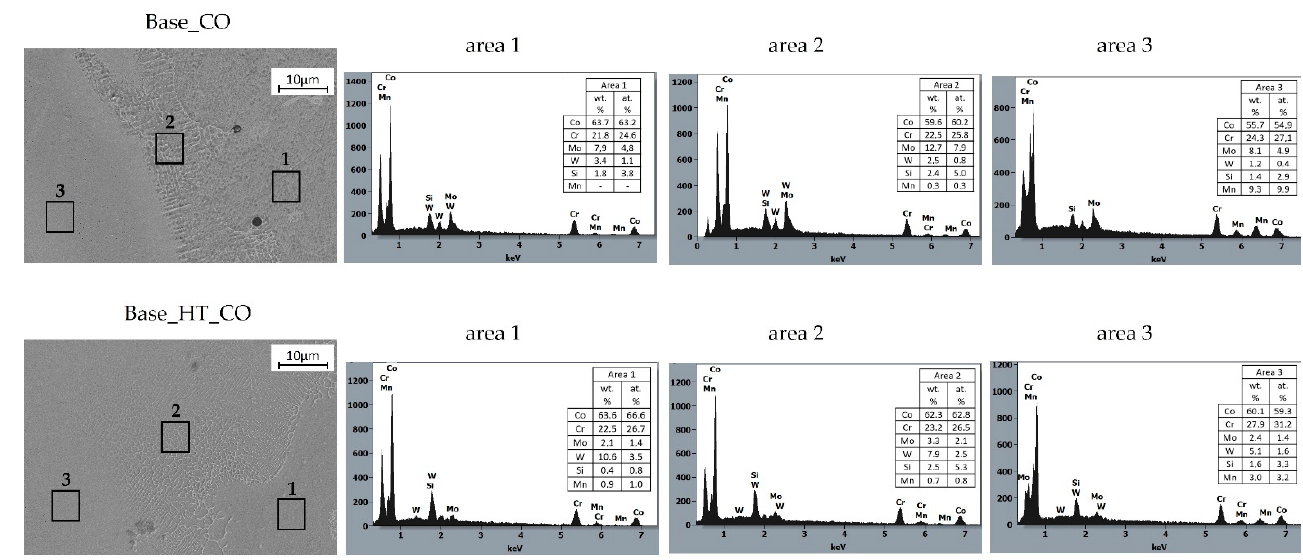
Figure 6. Microstructure and EDS analyses of CoCrMoW alloy welded with CoCr wire in as-welded conditions (Base_CO) and after heat treatment (Base_HT_CO).